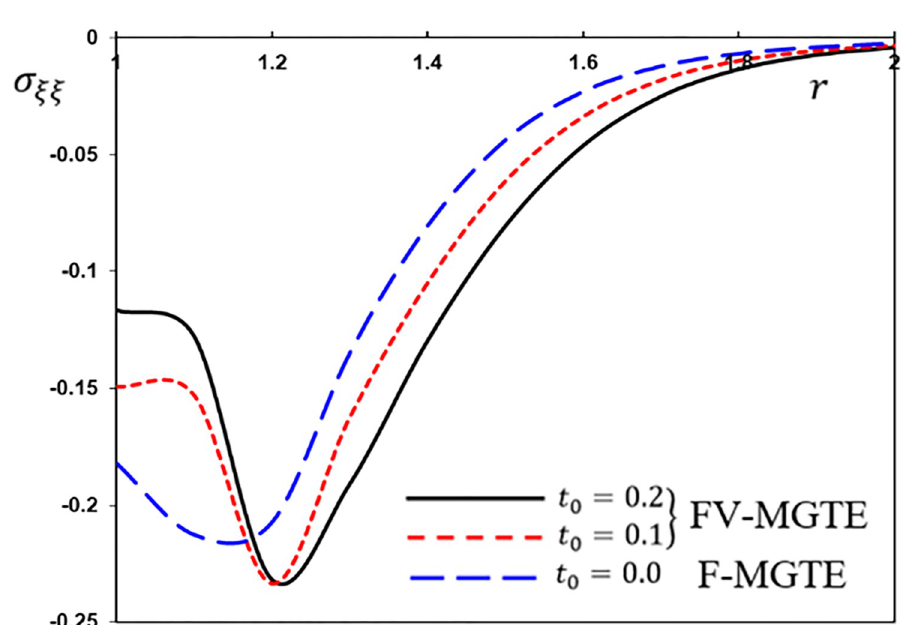
Fig 16. The hoop stress variation σ ξξ for different viscosity parameter η